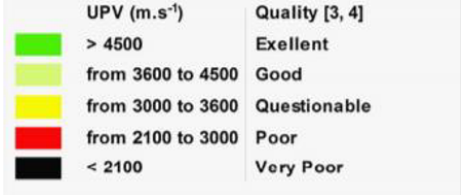
Figure 3. The Concrete Quality Designation (CQD) Derived from the